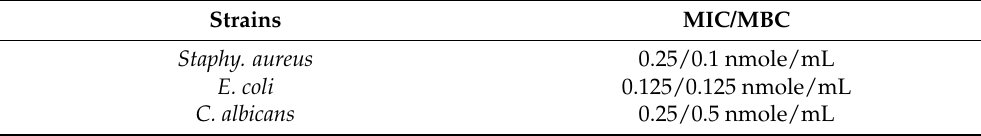
Table 1. MIC and MBC values of Au-NPs suspensions against different microbial